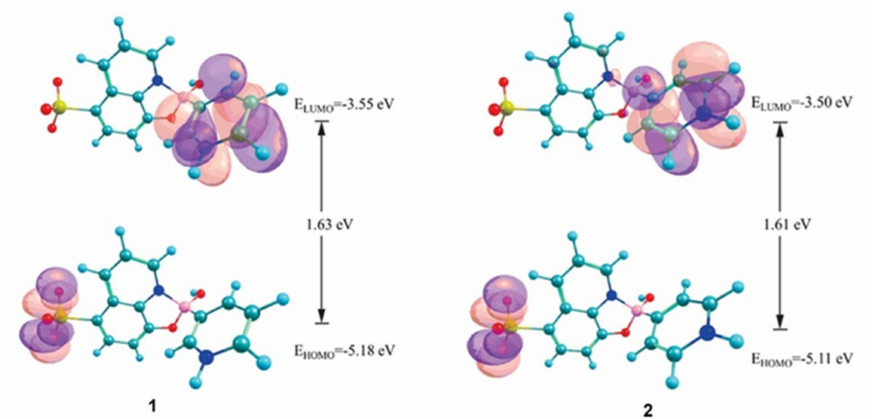
Figure 9. Molecular orbital surfaces computed at the M06/6-31G(d) level for the HOMO and LUMO orbitals of compounds 1 and 2